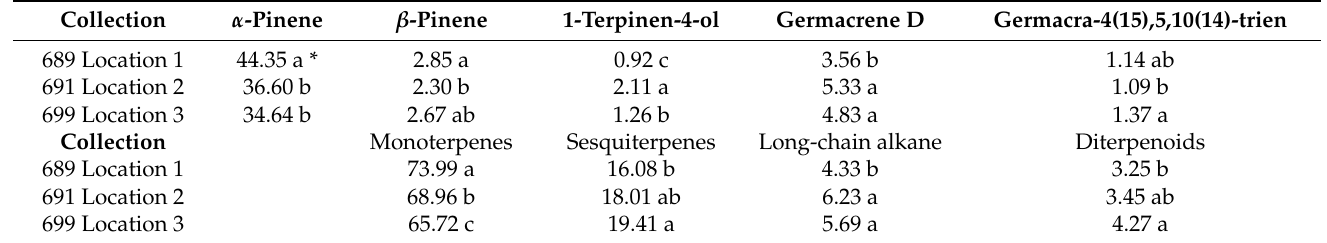
Table 3. Mean H. arenarium concentration (%) of α -pinene, β -pinene, 1-terpinen-4-ol, germacrene D,